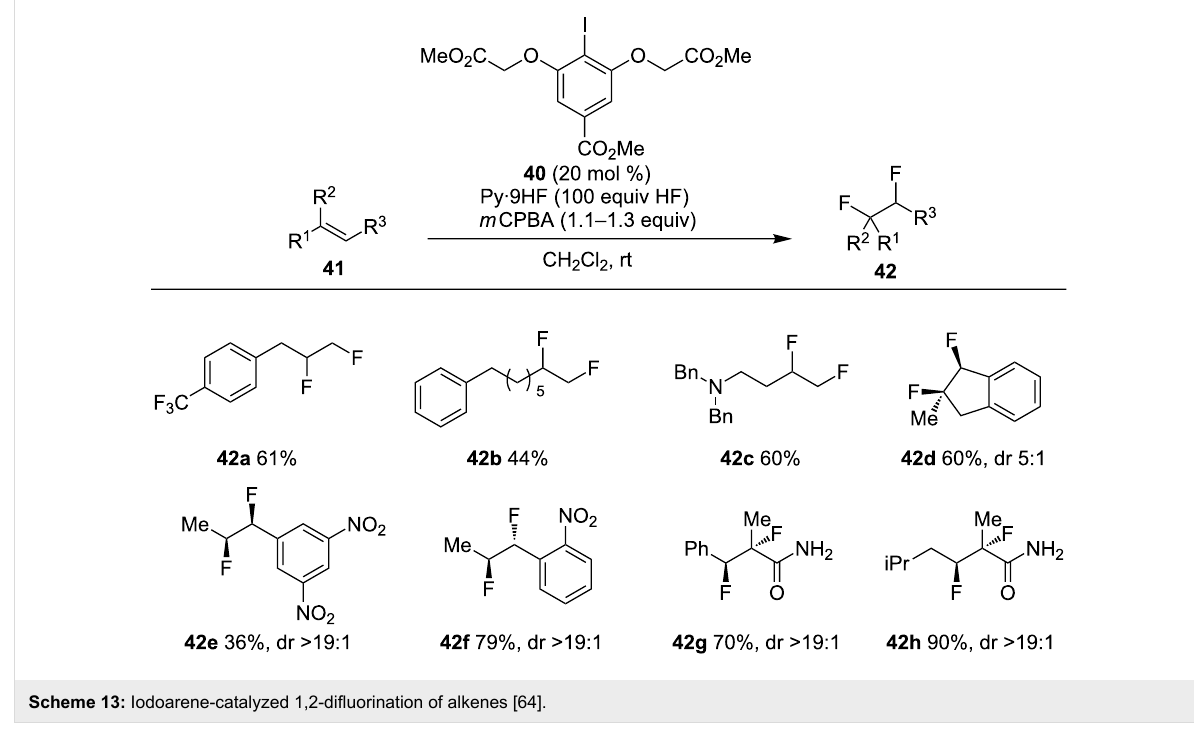
Scheme 13: Iodoarene-catalyzed 1,2-difluorination of alkenes [64].